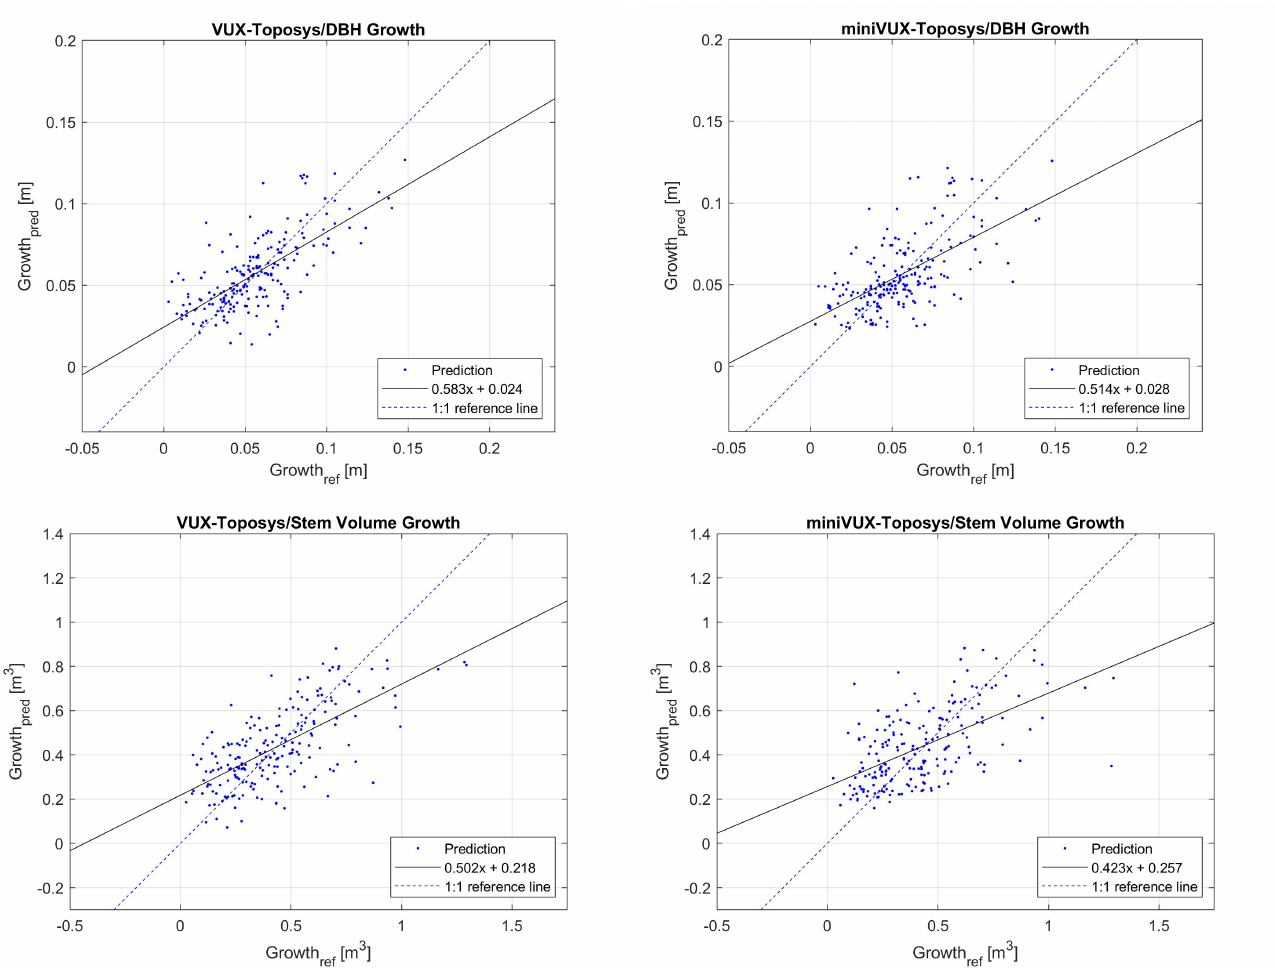
Figure 6. The accuracy of the direct growth determination. The black line is a least-squares